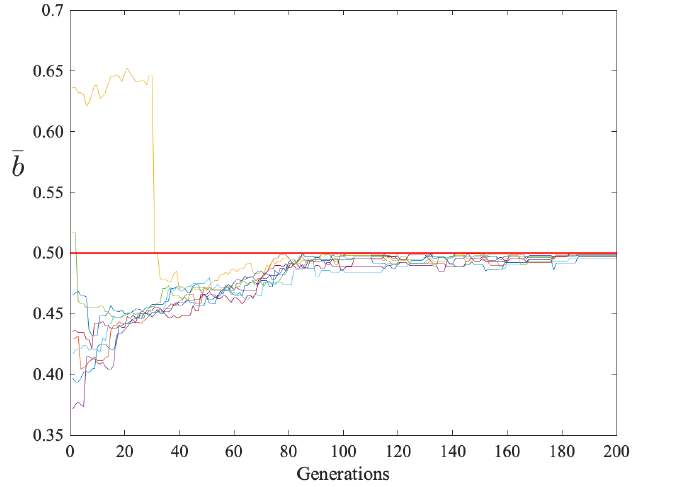
Figure 4. Row sample means versus generations for n = 10 players. There are 10 colored graphs, each showing how a player’s sample mean varied during evolution. The red line is at ¯ d = 0.5.